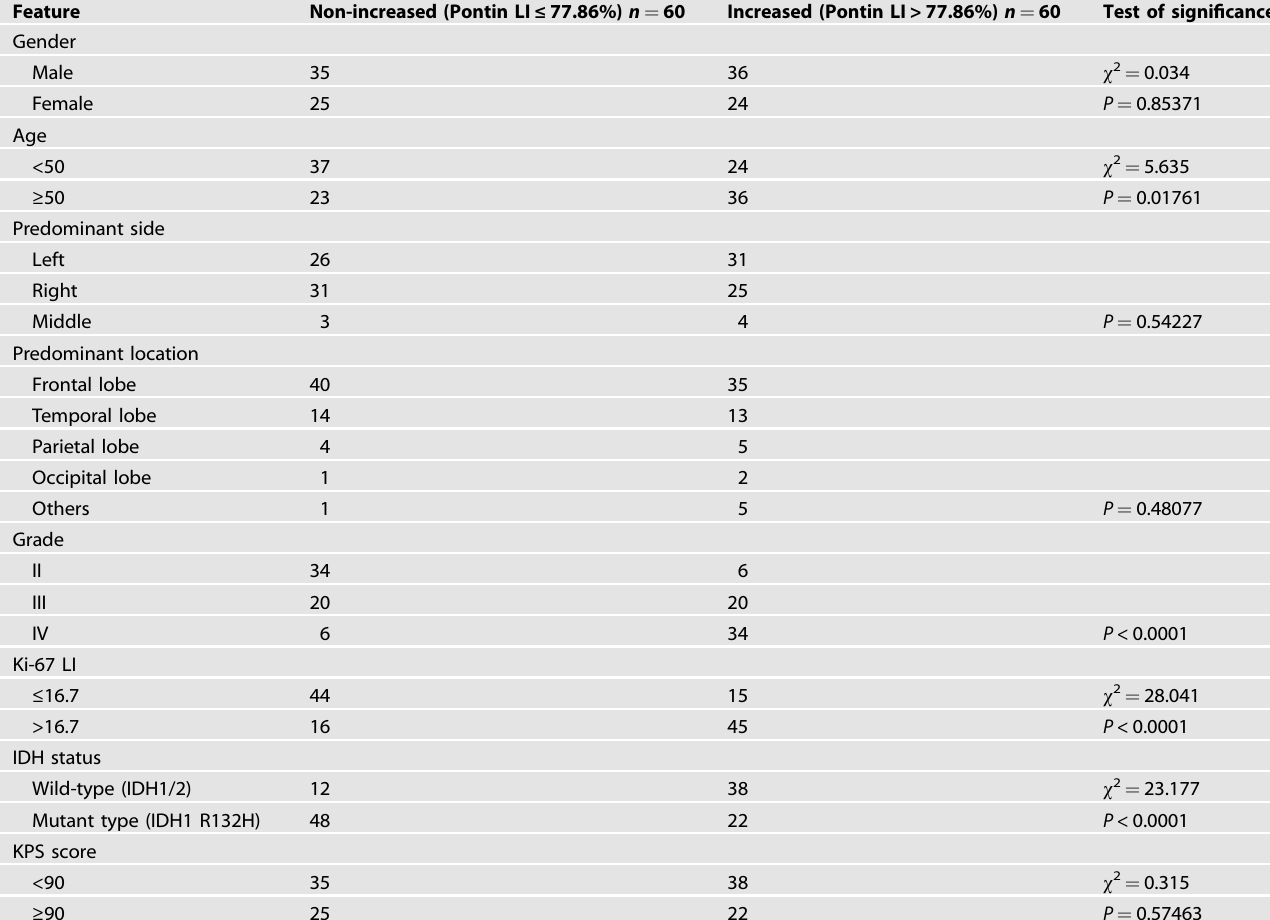
Table 1. Relationship between Pontin expression and clinicopathological characteristics of the 120 glioma